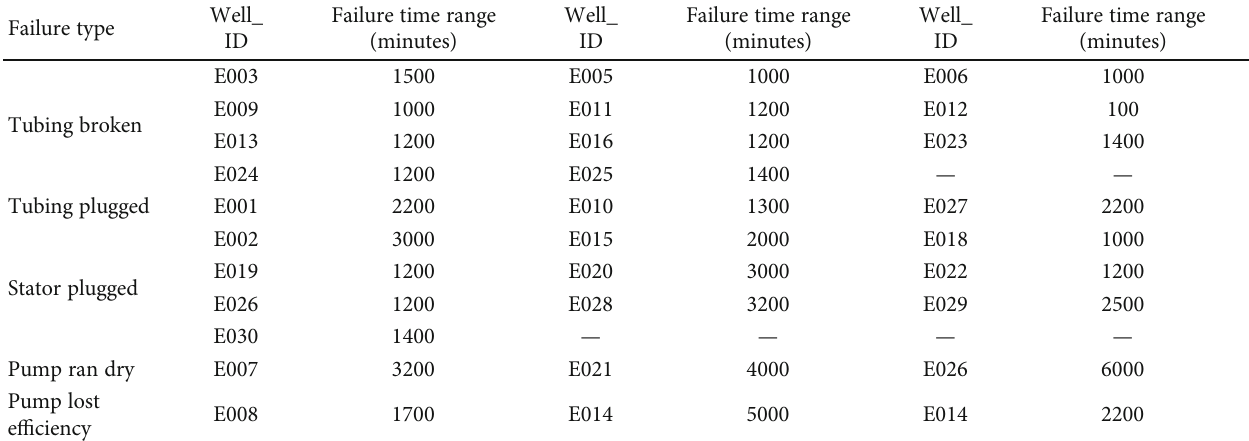
Table 6: Statistics of the failure time range of di ff erent failure types.